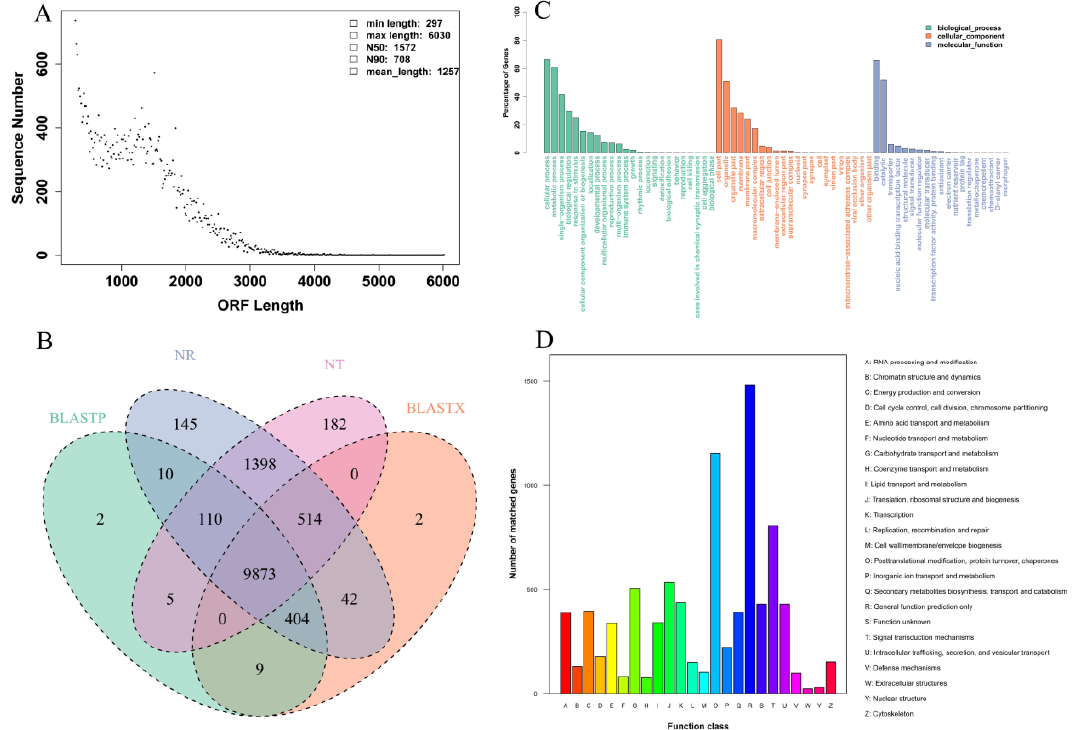
Figure 1. Basic information and annotation analysis of full-length transcripts. ( A ) ORF length distribution. ( B ) Comment result Venn diagram. ( C ) GO enrichment analysis of full-length transcripts for cellular component, biological process, and molecular function. ( D ) KOG annotation analysis of full-length transcripts.